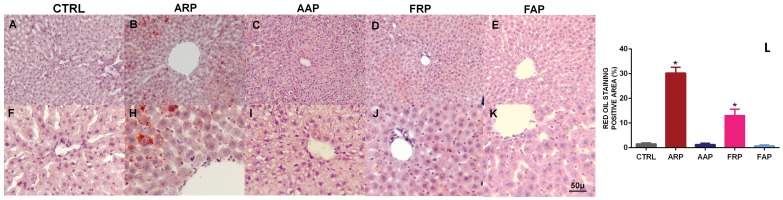
When rats are active and eat during the rest phase microvesicular steatosis were observed.Oil-Red-O staining of frozen sections of livers obtained from CTRL, ARP and AAP rats. Mayer’s hematoxylin was used for counterstaining. In ARP rats were observed typical lipid microdroplets that are indicative of microvesicular steatosis. In L is shown the mean of the area of the red oil positive tissues,; (P<0.0001).